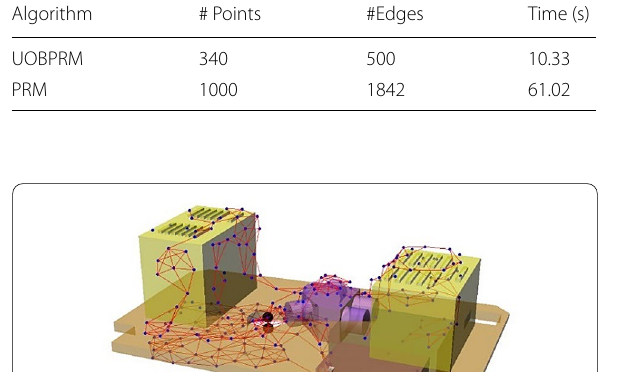
Table 1 Results of the PRM for the two scenarios Algorithm